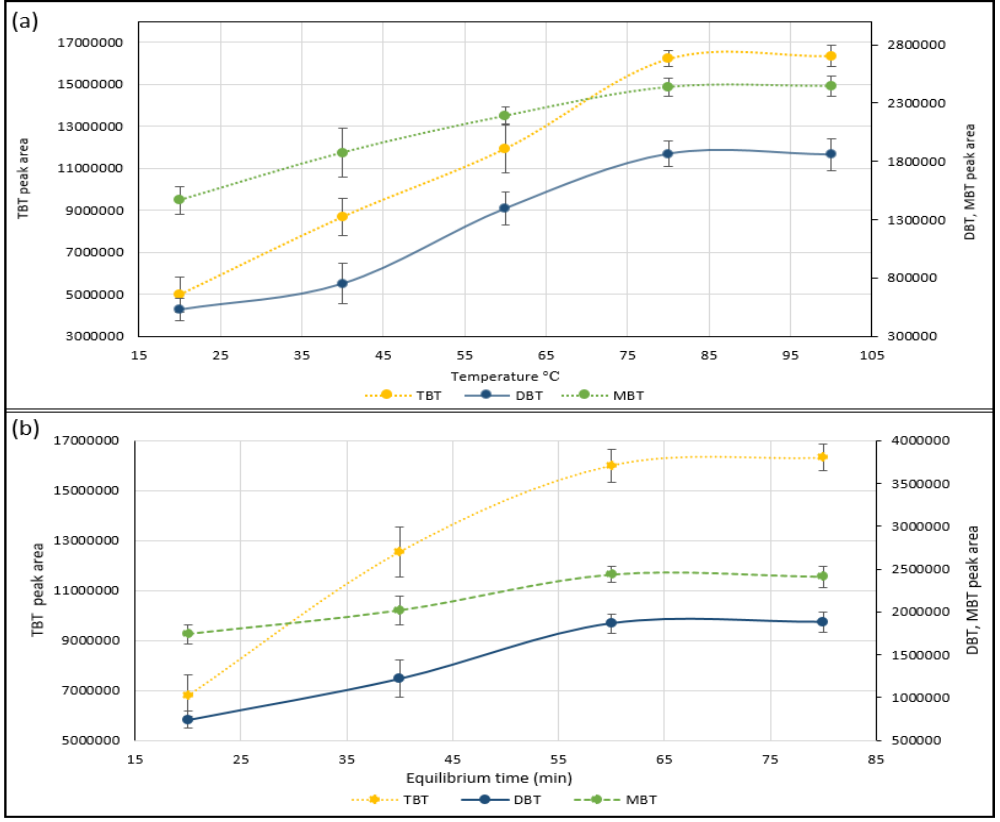
Figure 2. Optimization of the parameters affecting the extraction of organotin compounds TBT, DBT and MBT from 20 ng/g spiked sediment samples by repeated measures ( n = 3) against peak area; ( a ) reaction temperature between 20 °C and 100 °C was investigated for greater extraction yields of TBT, DBT and MBT in 20 °C increments; ( b ) reaction time was investigated to achieve a constant state of equilibrium for TBT, DBT and MBT from peak area against time profiles 20, 40, 60 and 80 min at 90 °C. Error bars represent the standard of the mean (SD±).